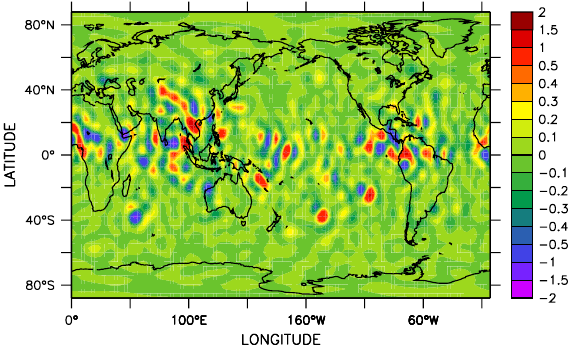
Fig. 2. Snapshot of the difference (in ms − 1 ) in zonal-wind velocity, about 4000m above ground, between two nudged simulations in coupled mode with the CCM EMAC. Output time: 4 June at seven p.m., 19h after initialization. The simulations share identical setup, initialization, executable, and nudging. The only difference is a 5% anomaly in NO emissions from road